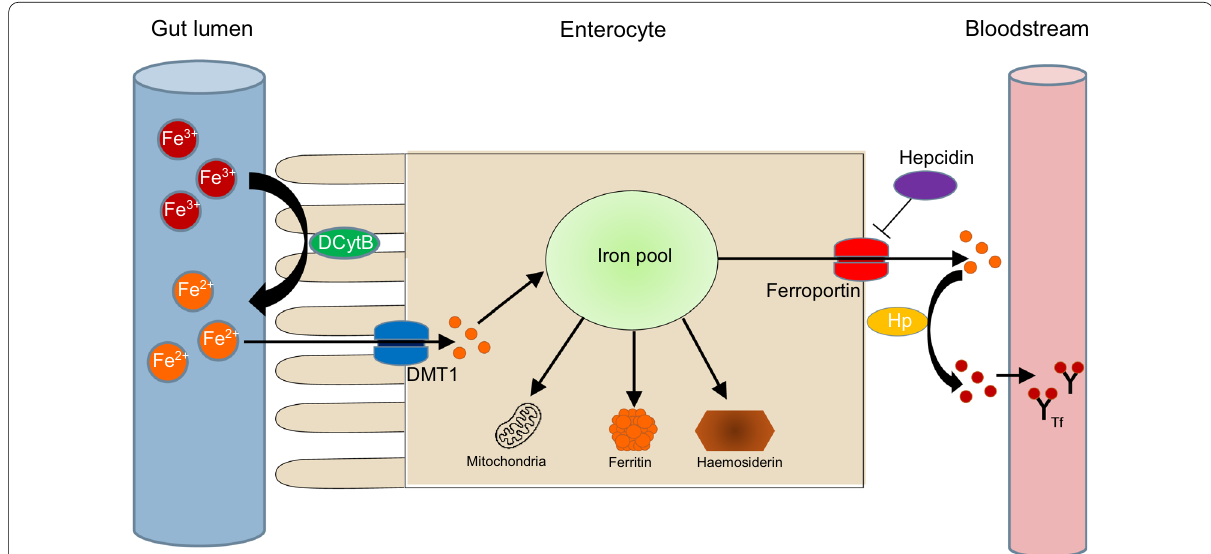
Fig. 1 Molecular pathway of iron absorption and homeostasis. Fe 3 + DMT1 divalent metal transporter 1; Hp =